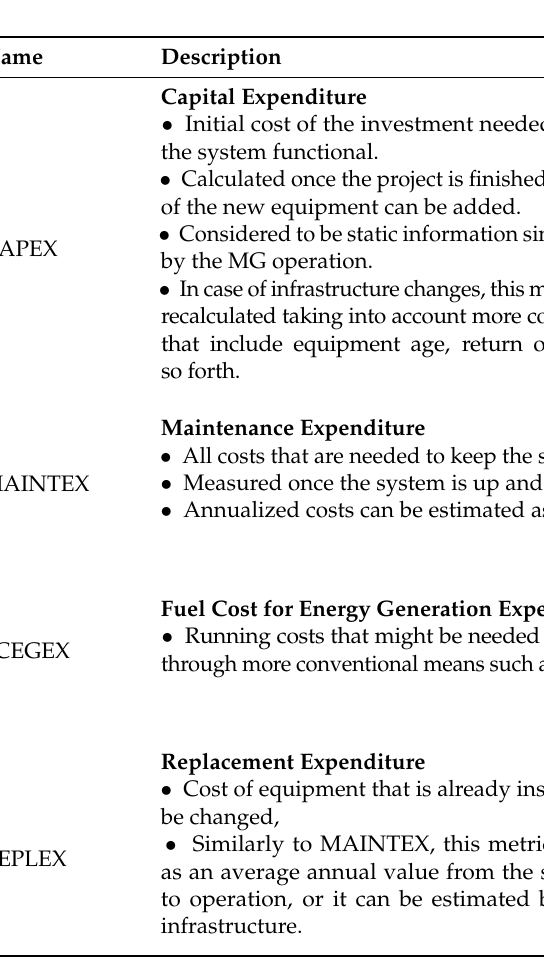
Table A1. Detailed Representation of MG Economic